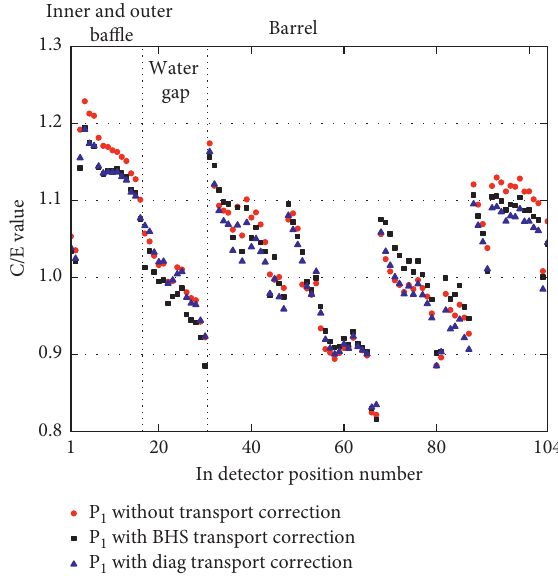
Figure 18: Comparison of P 115 In(n,n’) 1 transport correction of the 115m In